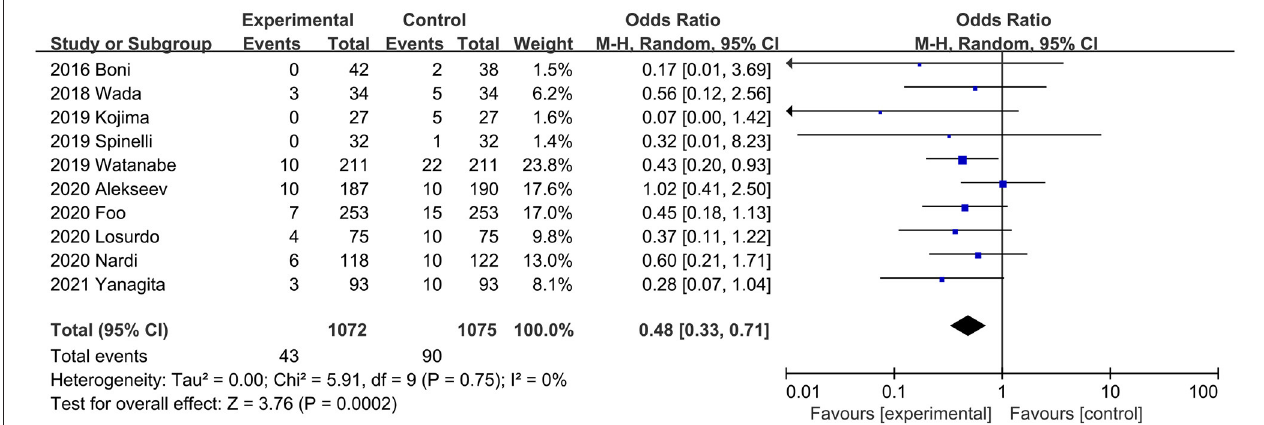
observed between